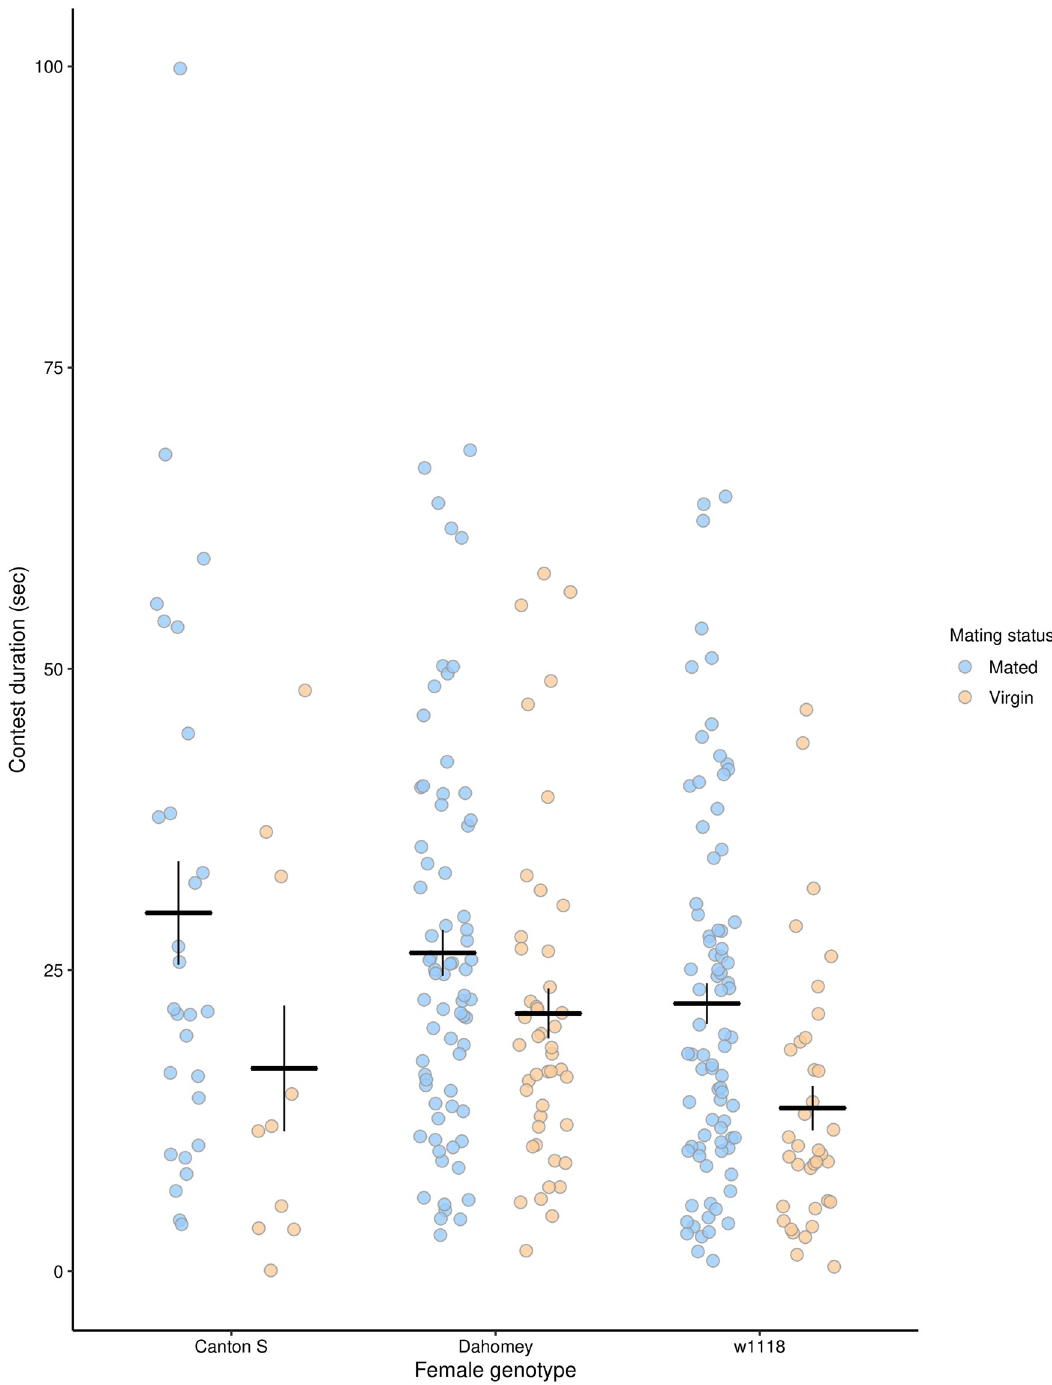
Fig 1. Mated females fought for longer than virgin females in all genotypes and w 1118 females fought for less time than Canton- S and Dahomey females. Blue points represent mated females while yellow points represent virgin females in each genotype. Each point represents the contest duration for one pair of females. The black bars represent the treatment means ± 1 standard error. Sample sizes are recorded in S1 Table.